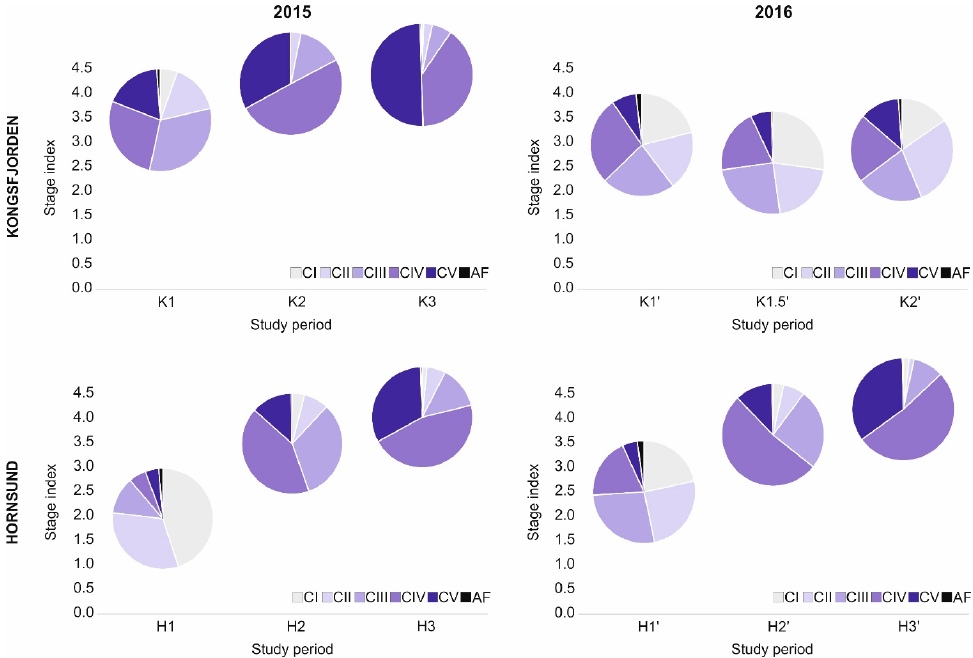
Figure 7. Calanus stage index (Y axis) together with copepodite stage structure (different colours) in Kongsfjorden and Hornsund in particular study periods (X axis) in 2015 and 2016.